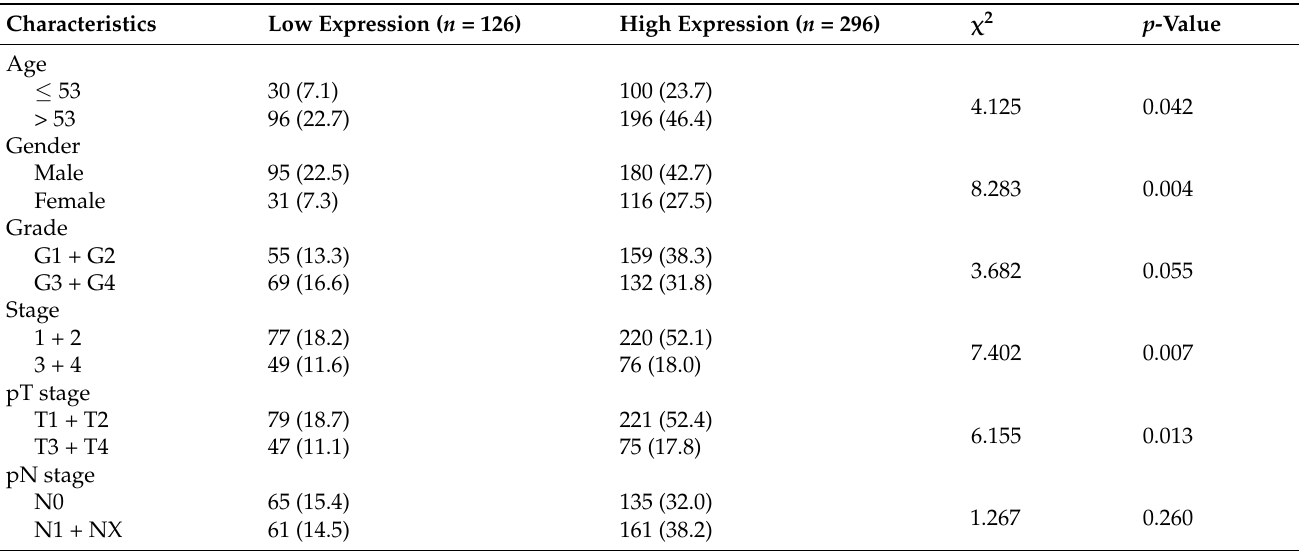
Table 2. Baseline clinicopathological characteristics of the TCGA non-metastasized ccRCC cohort according to ANO4